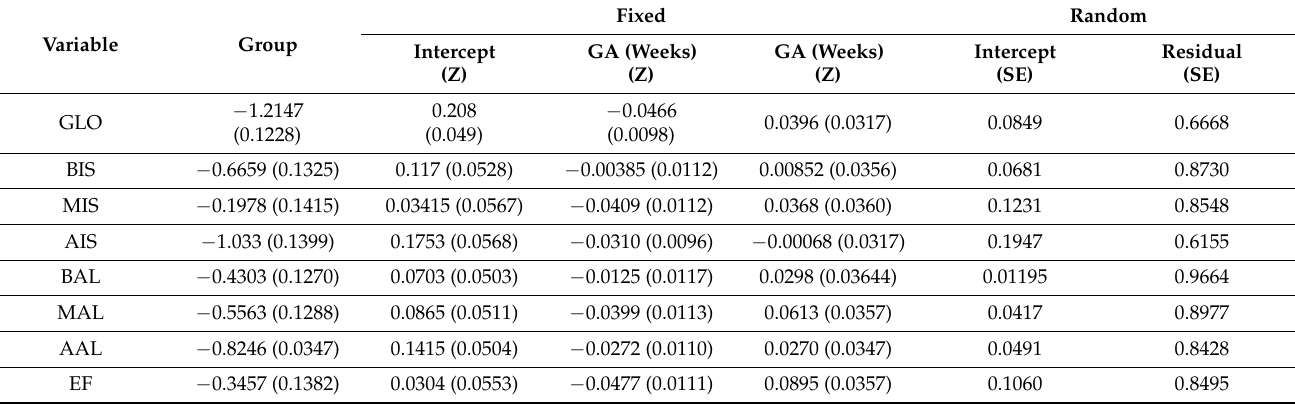
Table 2. Summary of linear mixed models for repeated measures of longitudinal strain values in